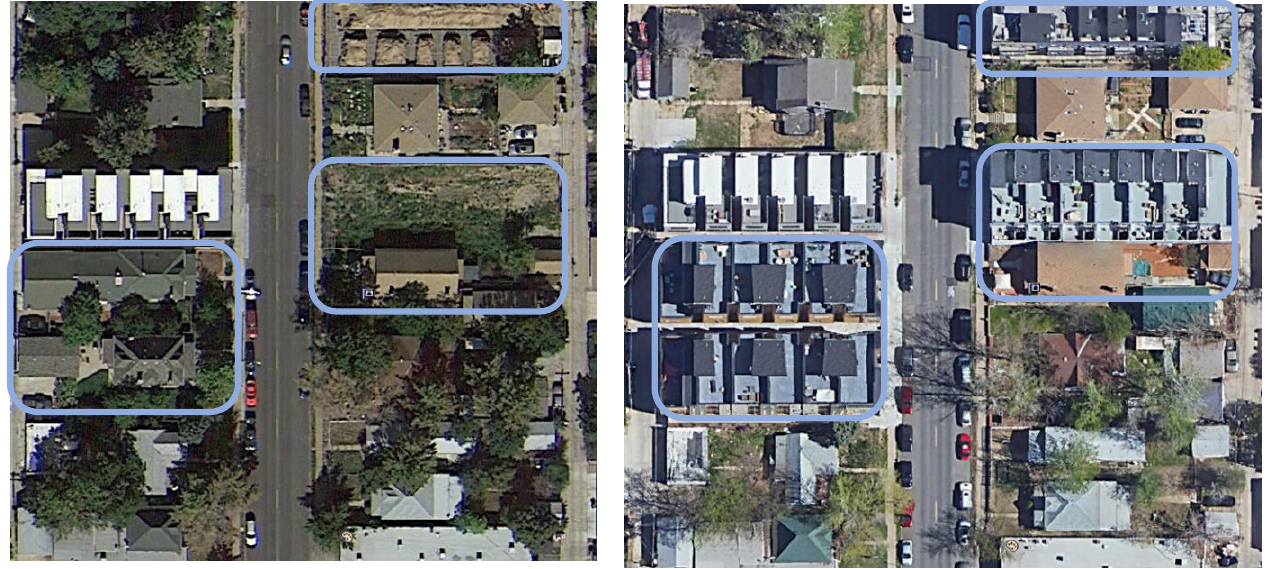
Figure 1. Redevelopment increasing impervious coverage in Denver. Left: pre-redevelopment in 2014; right: post-redevelopment in 2017. The street in the center is Tennyson Street (Images from Google Earth).